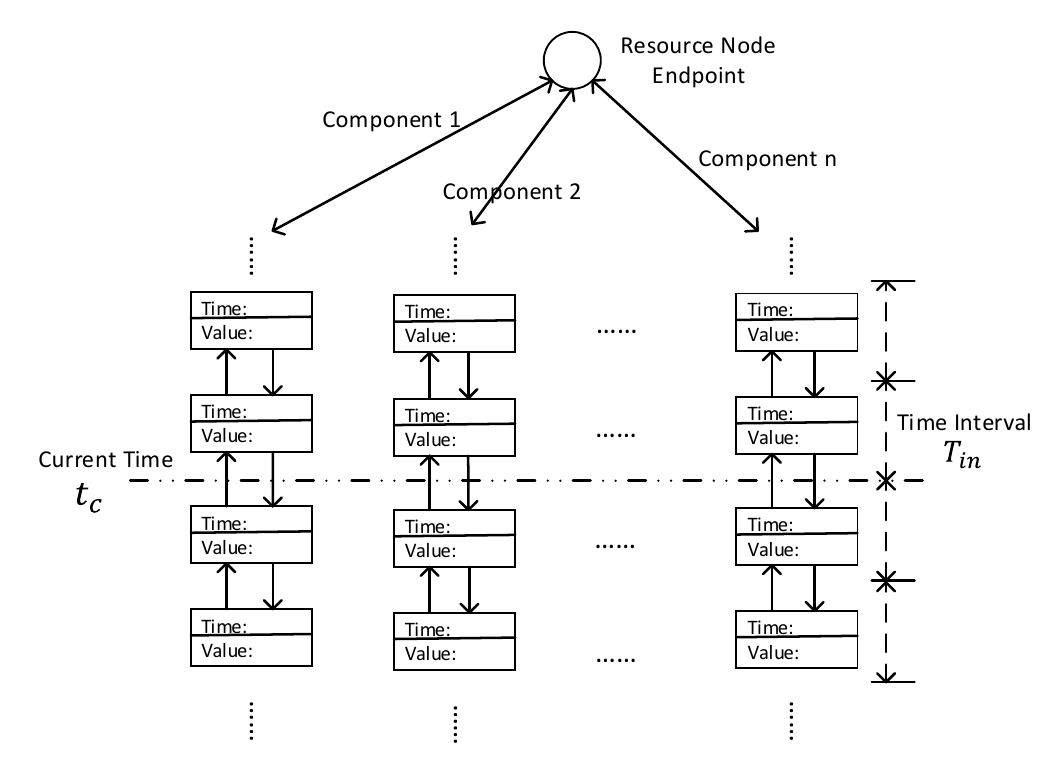
Figure 6. The data structure in the